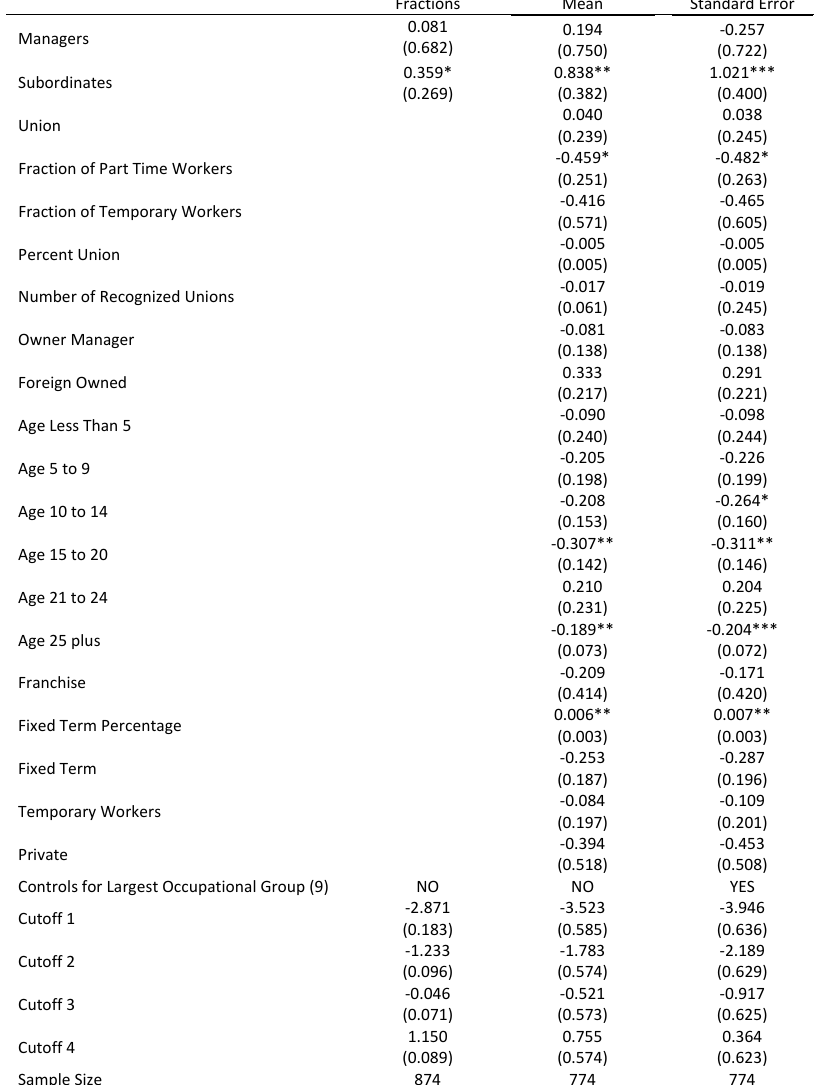
Table 5: Ordered Probit Models (Dependent Variable = Financial Performance)